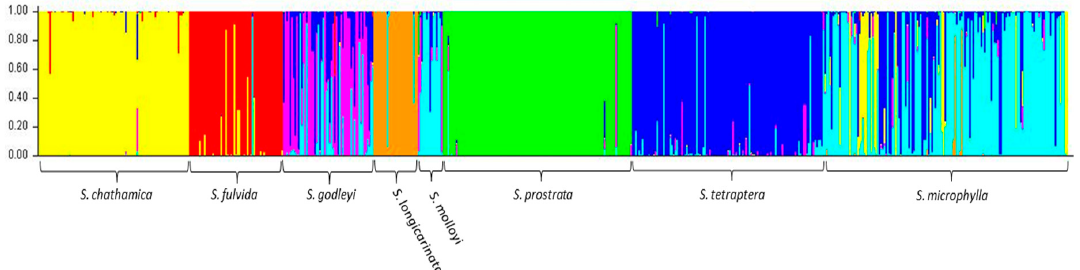
Figure 2. Output from Structure for the optimal value of K ( K 7). The colours refer to the genotype of each sample, with the samples being grouped by their morphological identification.